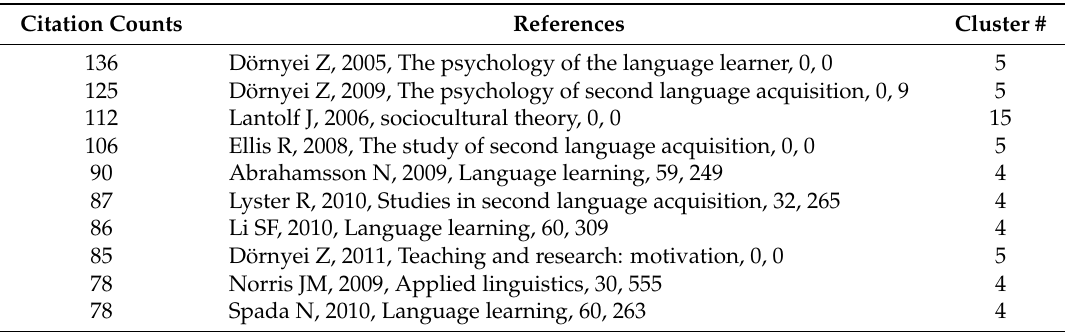
Figure 4. The timeline view of major research areas in SLA (1987–2018). Table 13. The top 10 most frequently cited references.